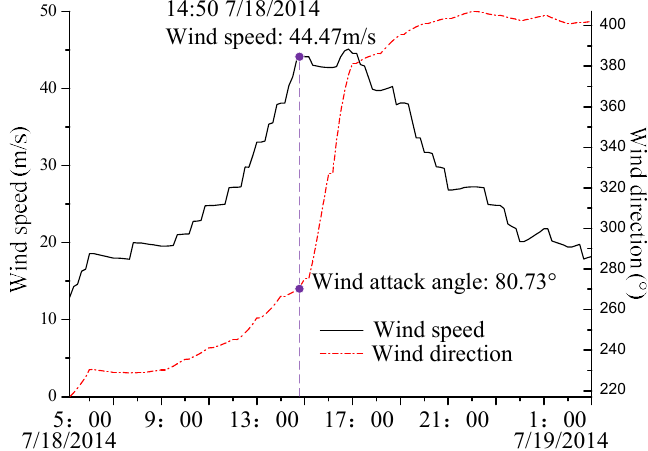
Figure 9. The average wind speed and direction of the Rammasun.